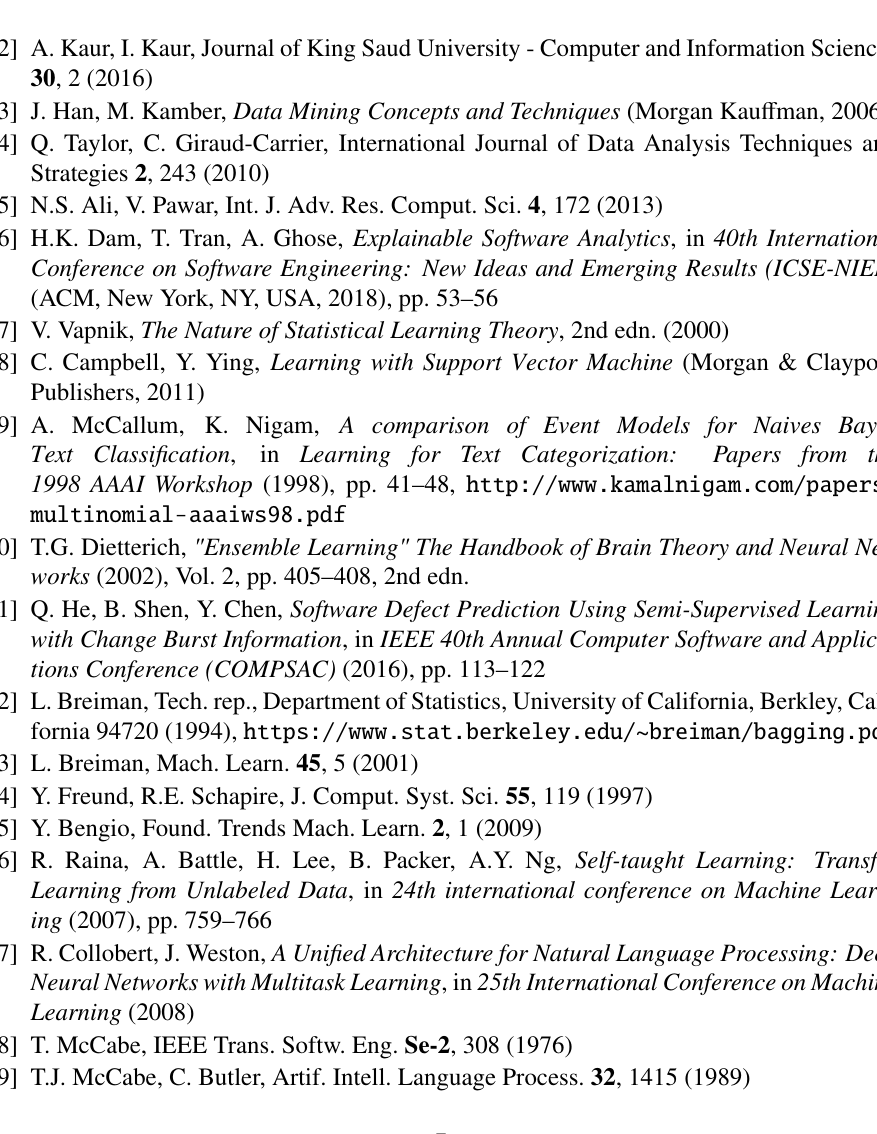
Figure 4. Average Accuracy for the Android and ElasticSearch